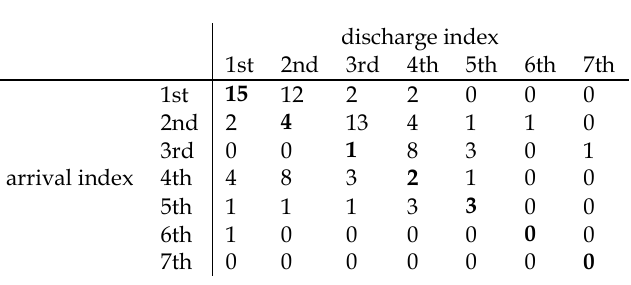
Arrival vs. discharge index for cyclists in the first channel